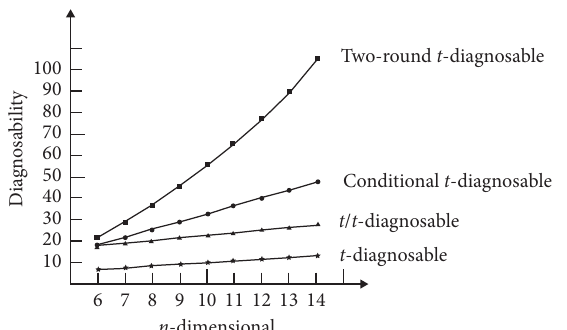
Figure 5: Comparison of the diagnosabilities of Q n between the traditional diagnosis approach and the two-round diagnosis Algorithm 1 is applied to each node of Q n with at most t